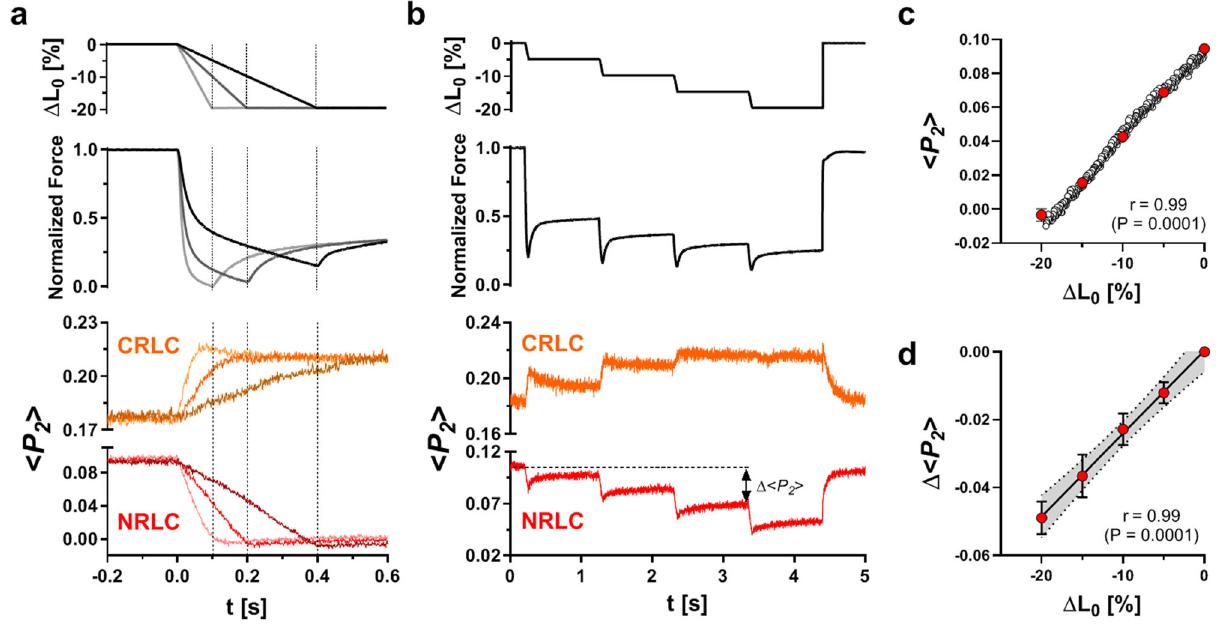
Fig. 4 Orientation changes of the NRLC and CRLC probe in response to ramp and staircase shortening. a NRLC (red) and CRLC probe orientation (orange) during ramp shortening of ventricular trabeculae at different velocities (2 L 0 /s, light grey; 1 L 0 /s, dark grey; 0.5 L 0 /s, black). b Staircase ramp release protocol. Top: muscle length. Middle: force response during the mechanical protocol. Bottom: < P 2 > for the NRLC (red) and CRLC probe (orange). c Length-dependence of < P 2 > from the NRLC probe during ramp shortening (pooled data from a shown as open circles). Average < P 2 > at 0%, 5%, 10%, 15% and 20% shortening over all ramp shortening velocities is shown as red circles ( n = 3 trabeculae). The Pearson correlation coef fi cient (r) is shown on the bottom right. Statistical signi fi cance was assessed with a two-tailed student ’ s t test. d Plot of < P 2 > change ( Δ < P 2 >) for the NRLC probe in the staircase protocol versus muscle length change ( n = 4 trabeculae). The P earson correlation coef fi cient (r) is shown on the bottom right. Statistical signi fi cance was assessed with a two-tailed student ’ s t test. Data are shown as means ± s.e.m. Source data are provided as a Source Data fi